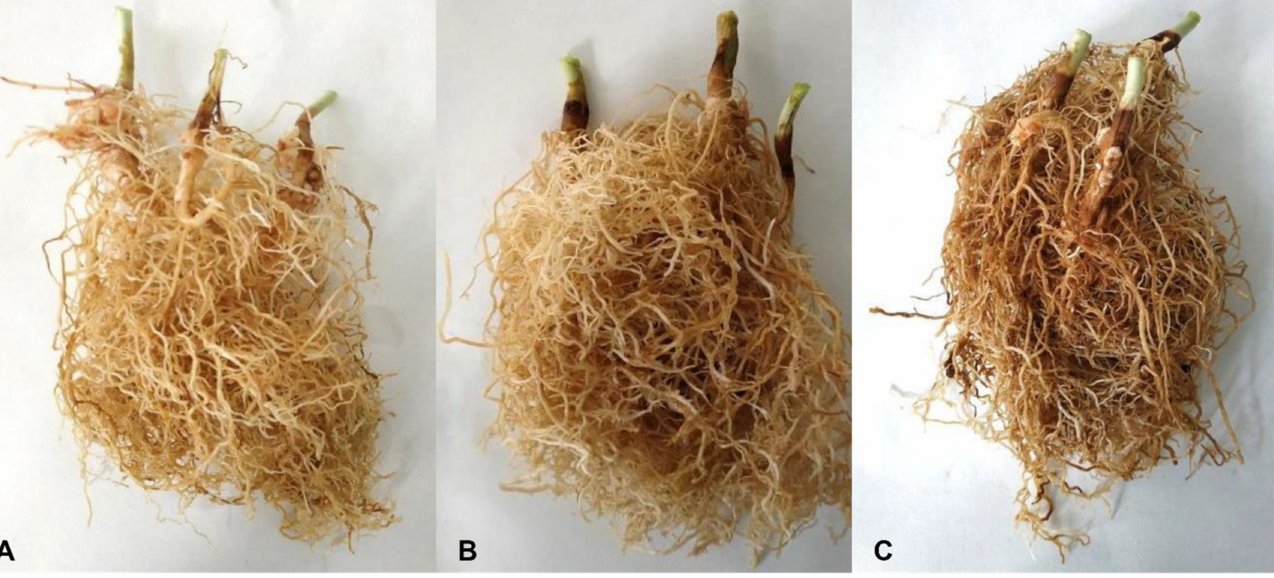
Figure 8. Roots of control white lupin plants ( A ) plants treated with FMBO ( B ), and plants treated with AMO ( C ) after 35 days of NMOs